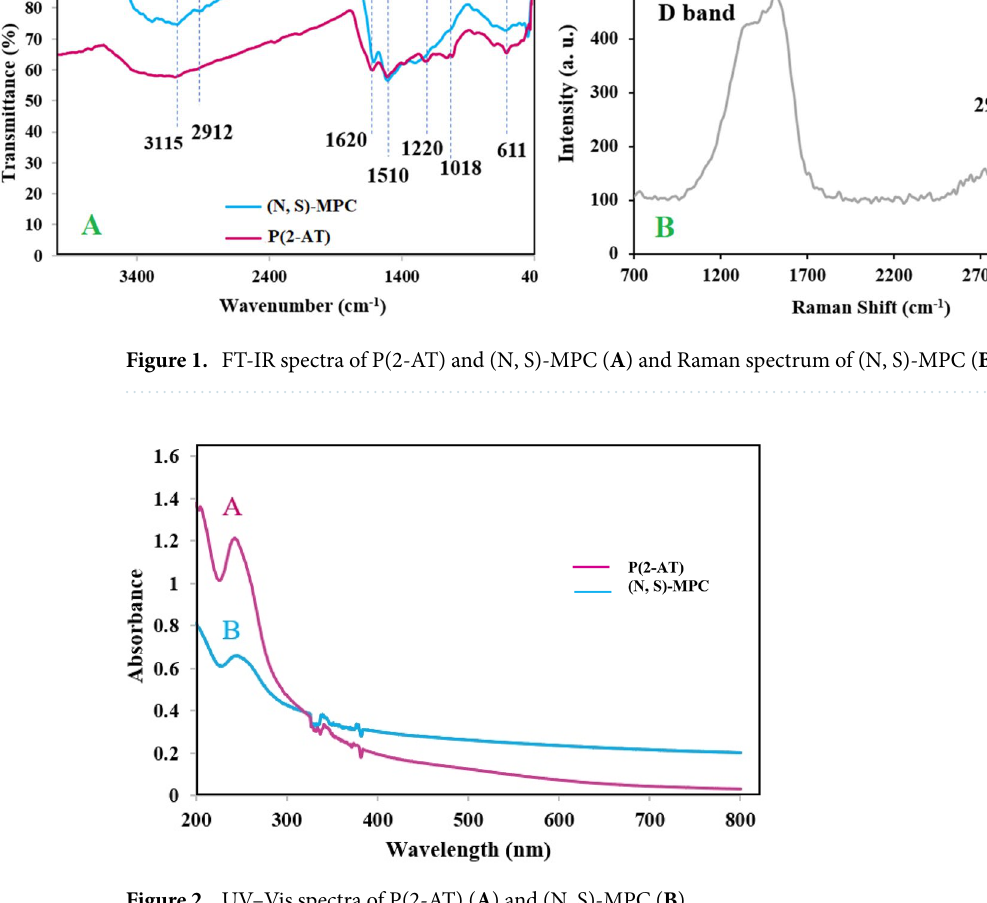
Figure 2. UV–Vis spectra of P(2-AT) ( A ) and (N, S)-MPC ( B